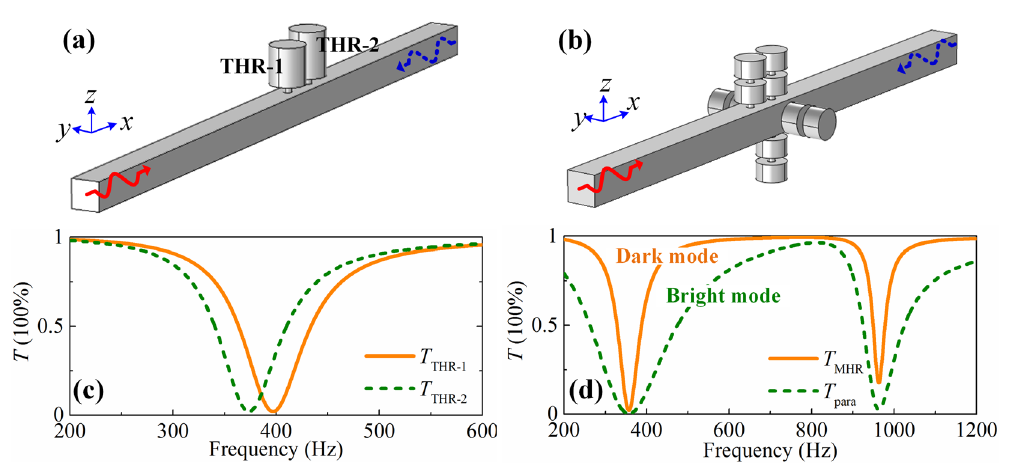
Figure 6. (a) 3D view of the asymmetric absorptive system presented in ref. 19 and (b) in this work (also see Fig. 2(b)). ( c ) and ( d ) are the transmittances of corresponding